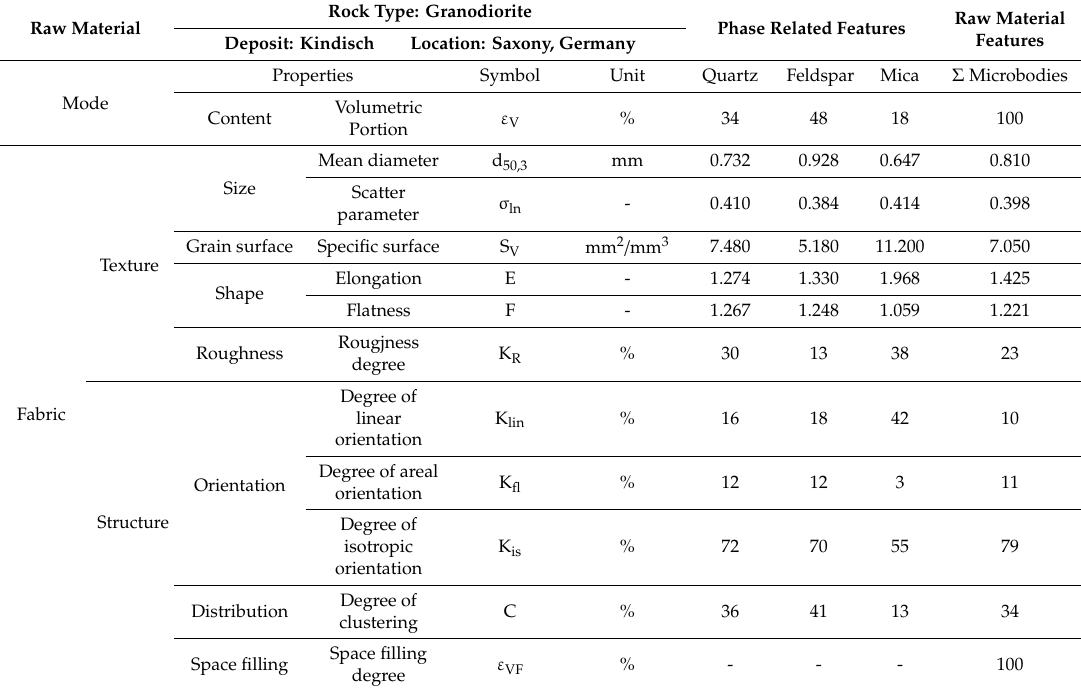
Table 1. Rock characteristics as established by QMA under the optical